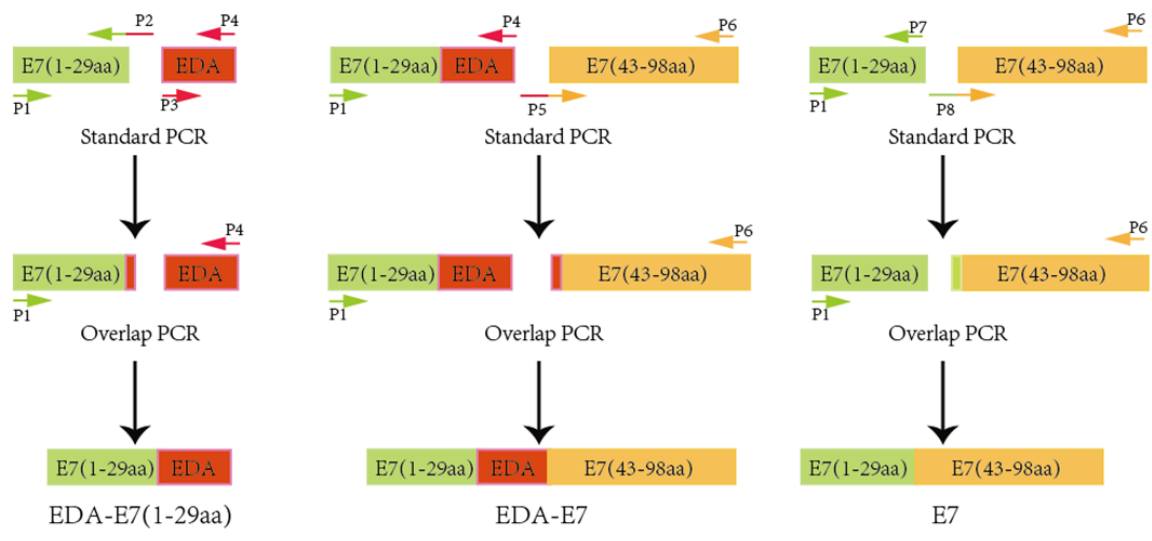
Figure 1. Schematic diagram for EDA-E7 and E7 PCR strategy.